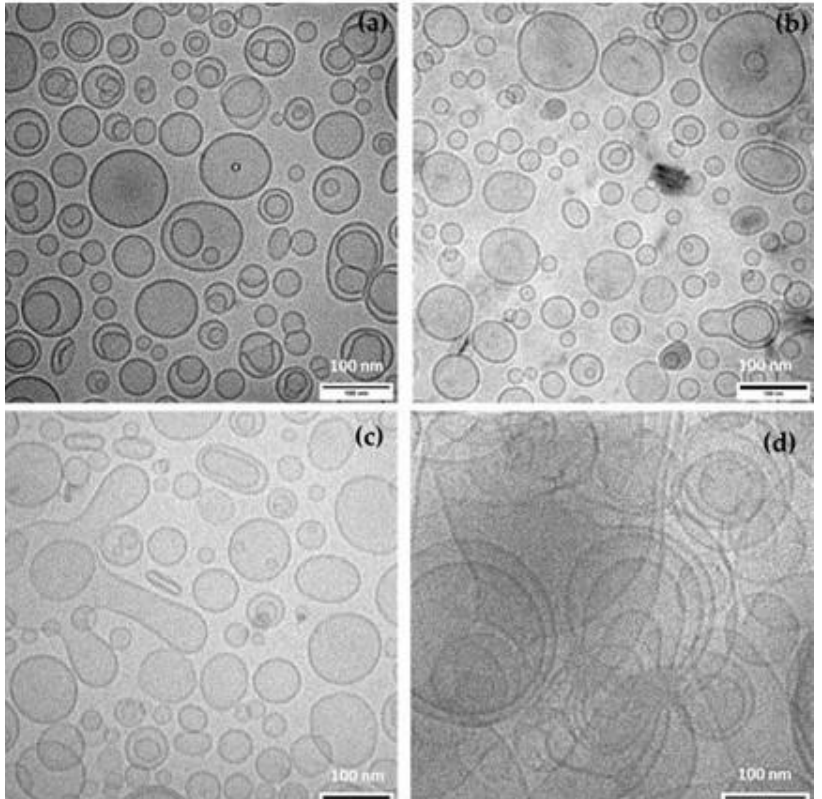
Figure 1. Cryo-TEM images of liposomal dispersions: ( a ) L-Hx 5 : Liposomes encapsulating 5% Hexane-Soluble Extract; ( b ) L-Ac 5 : Liposomes encapsulating 5% Acetone-Soluble Extract; ( c ) L-Ac 10 : Liposomes encapsulating 10% Acetone-Soluble Extract; ( d ) L-PL low : Empty liposomes made of low purified phospholipid